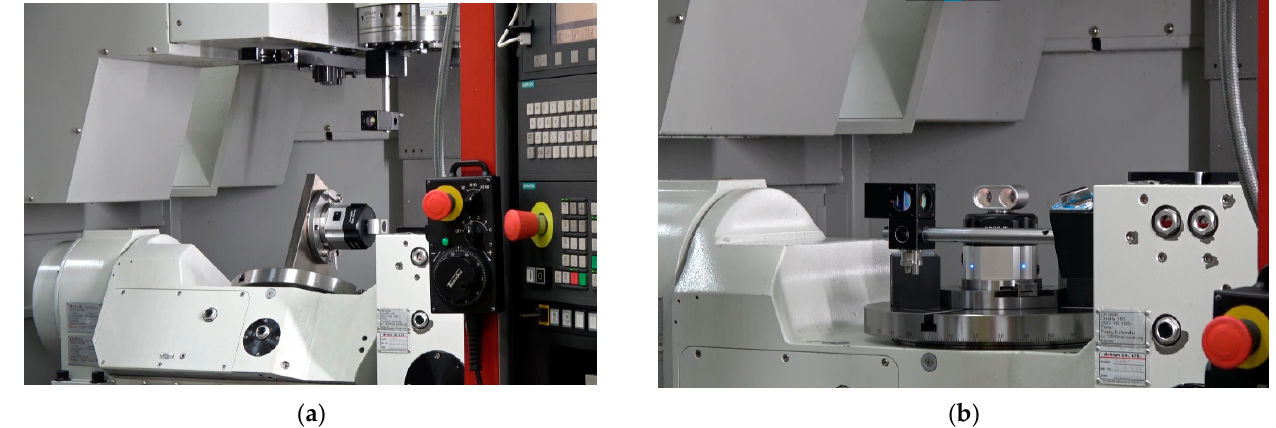
Figure 16. The picture of Renishaw XR-20: ( a ) installation for measuring the A-axis; ( b ) installation for measuring the C-axis.